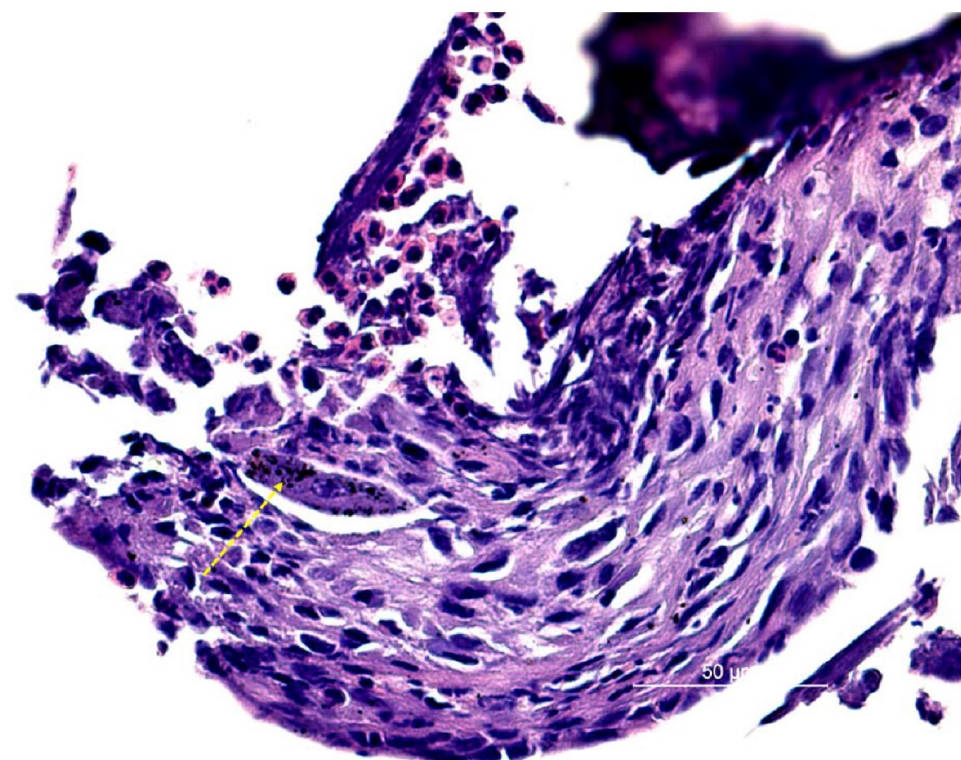
Figure 1: Intratissutal and intracellular accumulation of hyperchromic particles representing multiple foci of exogenous cement (see the arrow). Surrounding stroma is infiltrated by acute and chronic inflammatory